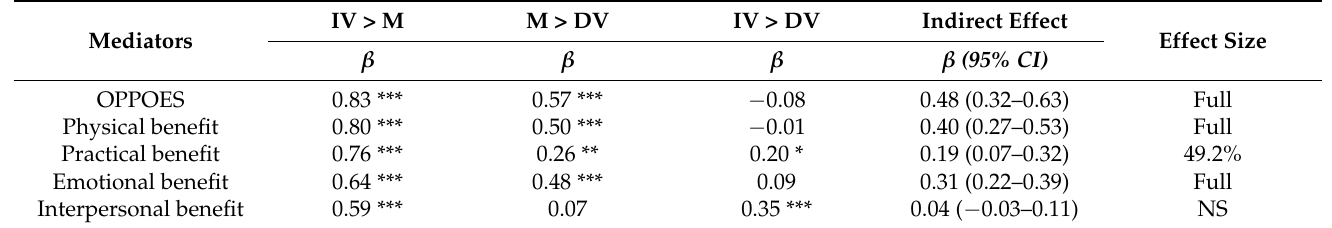
Table 2. Path analysis testing the mediation effect of personal POE between societal POE and CSFCV (n = 500).